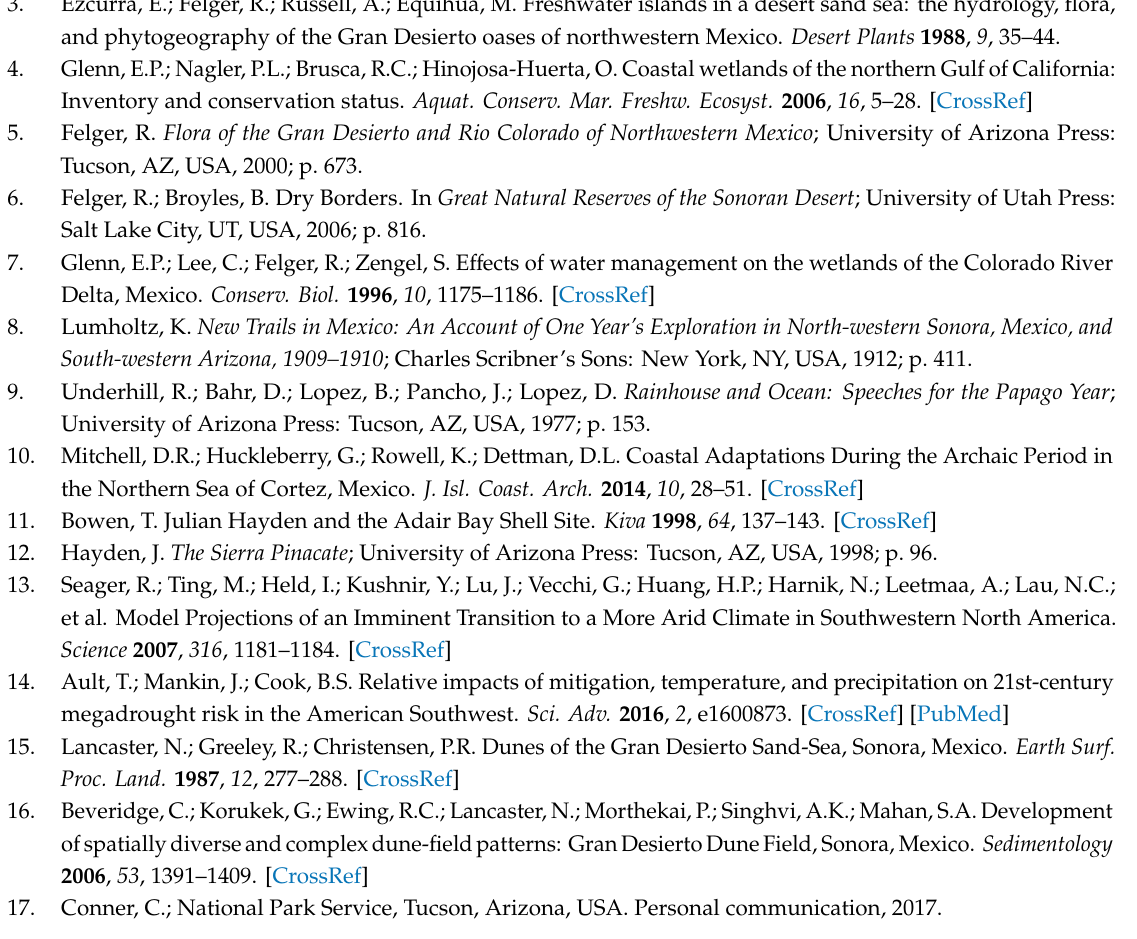
Table S1: Ion chemistry and stable isotope data of surface and groundwaters, Table S2: Stable isotopes in rainfall collected at